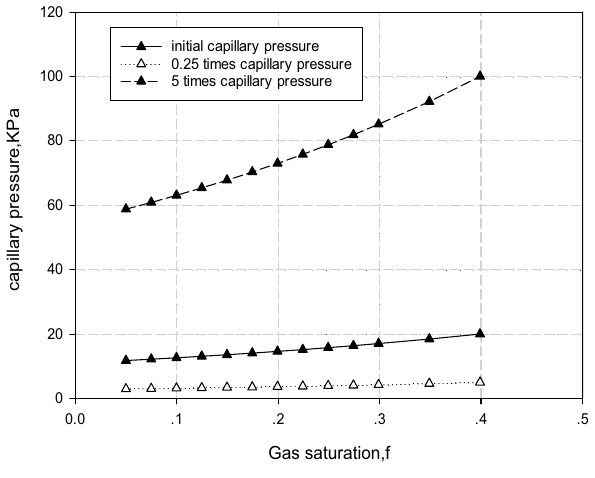
Fig. 9 Capillary pressure curve for different schemes (experiment